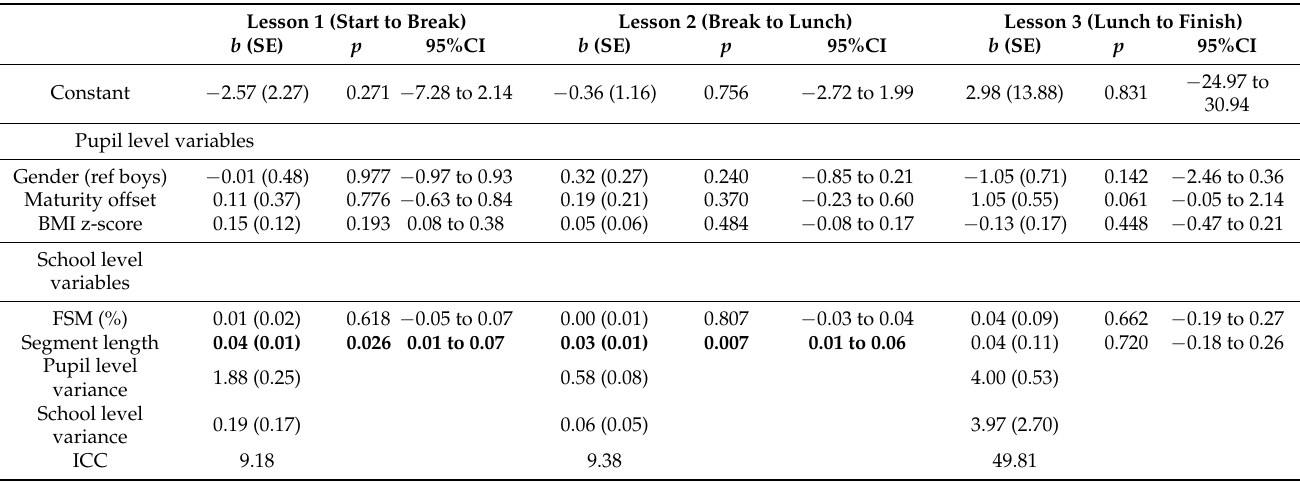
Table 3. Multi-level associations between pupil- and school-level predictors and moderate-to-vigorous physical activity across academic